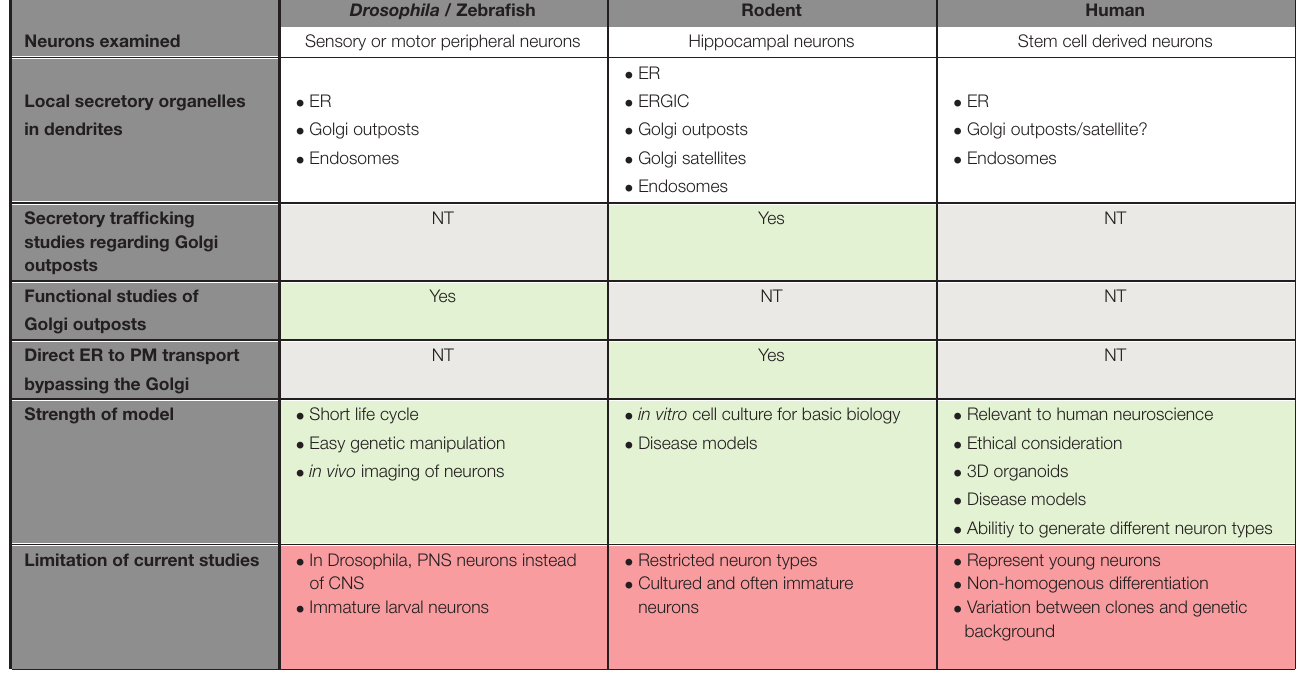
TABLE 1 | Comparison of organization and trafficking studies associated with the secretory pathway of neurons in different model